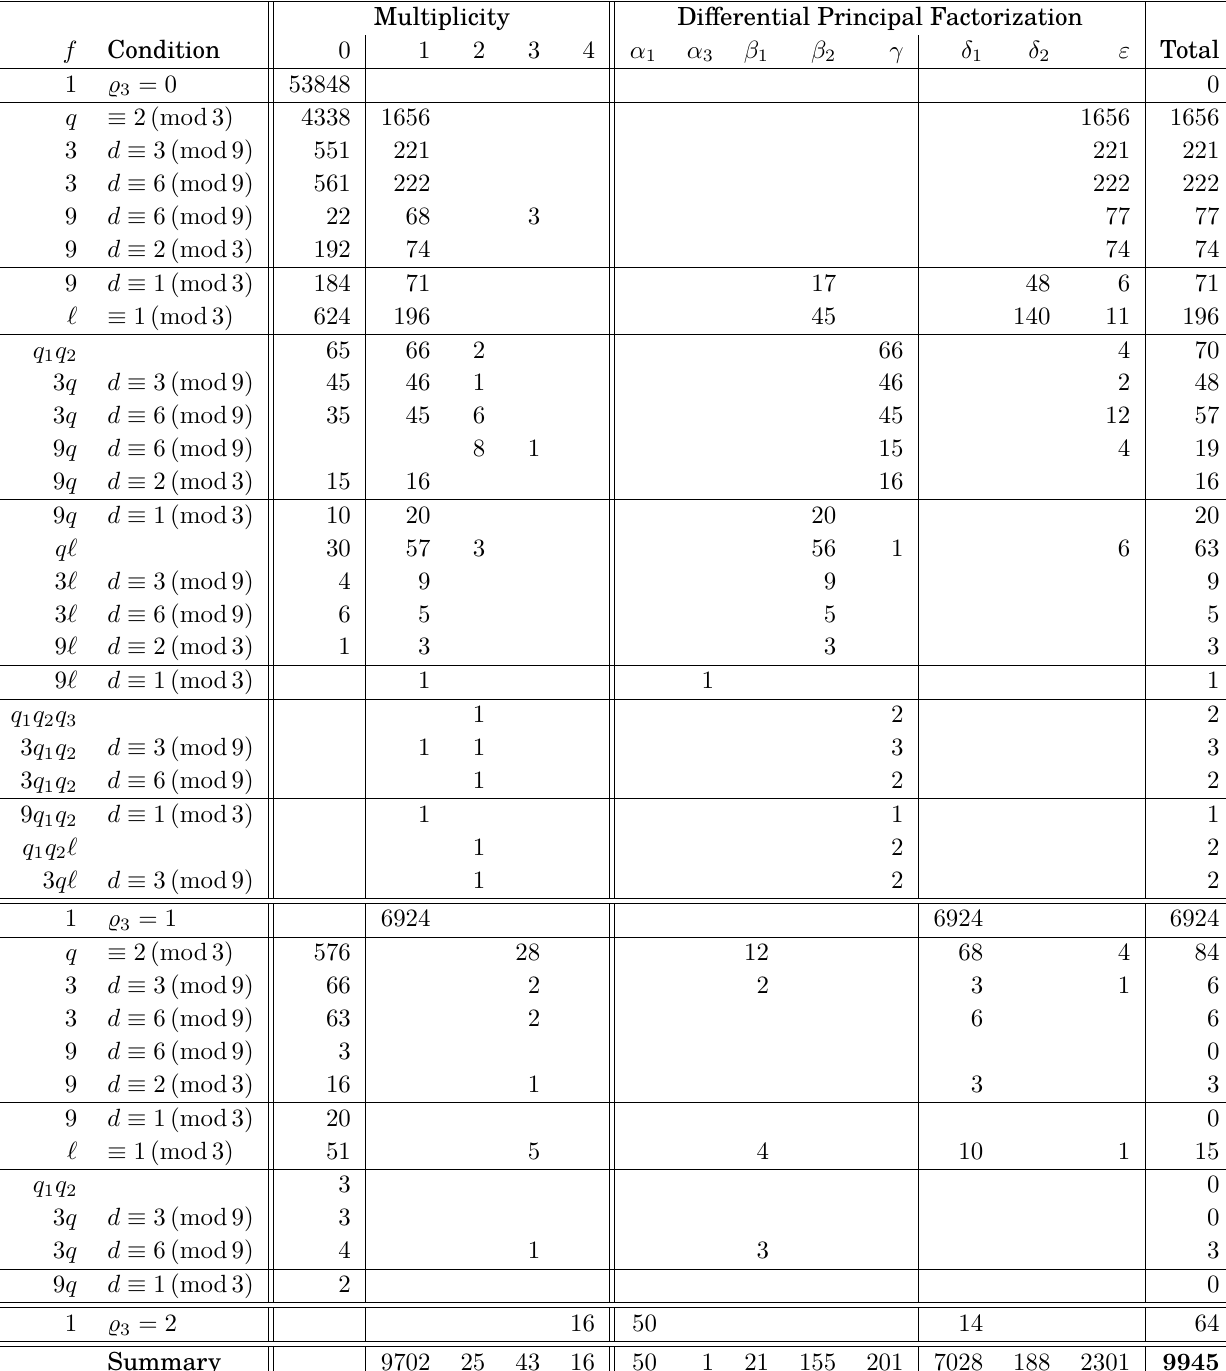
Table 6: Totally real cubic discriminants d L = f 2 · d in the range 0 < d L < 2 · 10 5 . Multiplicity Differential Principal Factorization